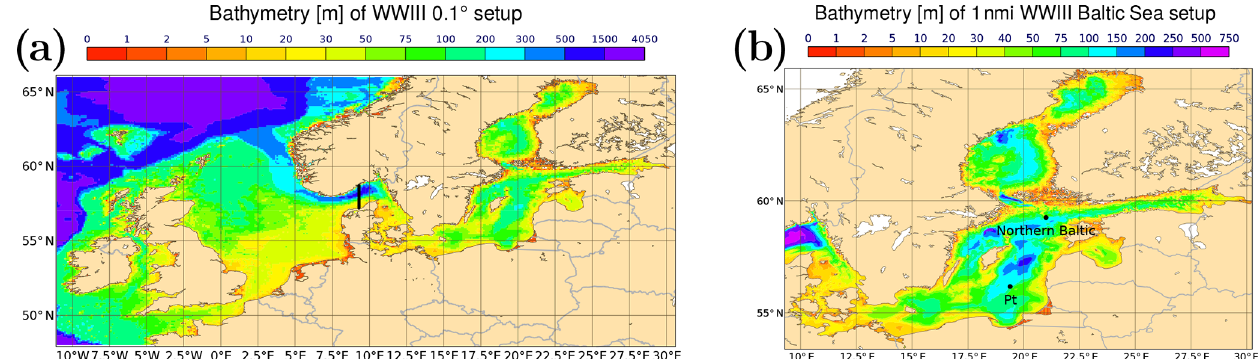
Figure 1. Bathymetries (m) and domains of (a) 0.1 ◦ and (b) 1nmi (nautical mile) WAVEWATCH III ® setups; in black in the left panel, (a) grid cells for the nesting of the Baltic Sea model are shown. The black point “Pt” in the right panel (b) shows the location of the time series in Fig. 2, and the black point “Northern Baltic” is the location of the time series in Fig. 6.